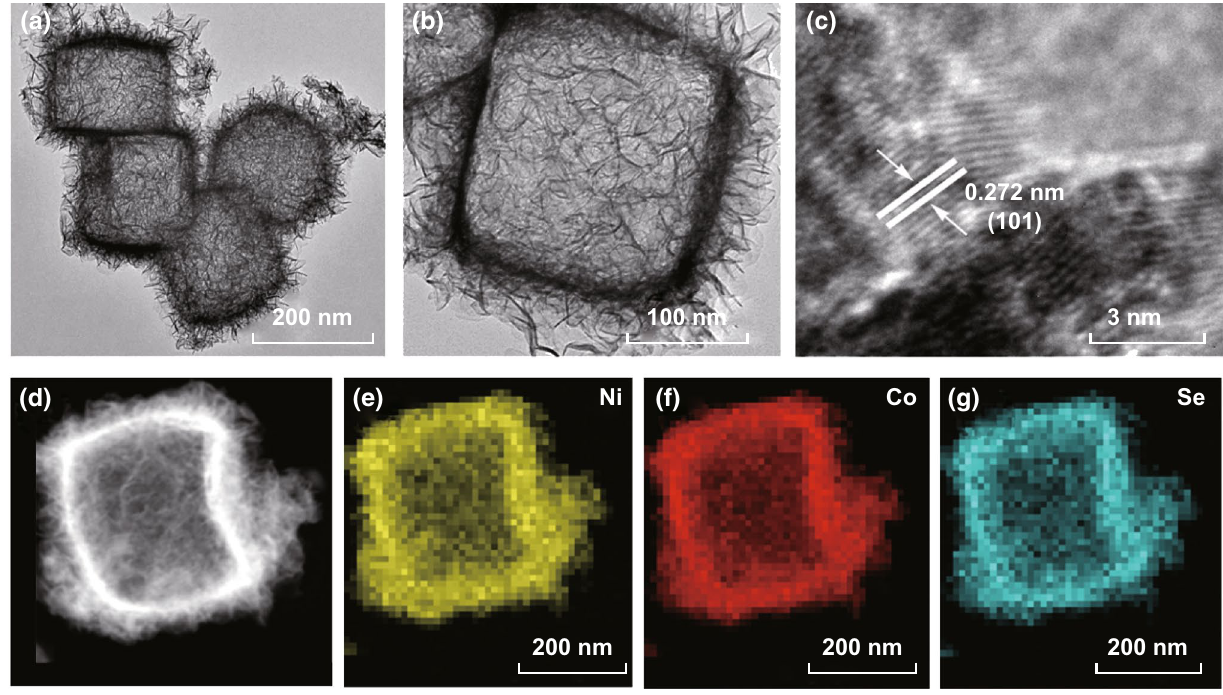
Fig. 2 a – c Representative TEM and HRTEM images of the Ni 0.2 Co 0.8 Se nanocages. d HAADF‑STEM image of Ni 0.2 Co 0.8 Se and e – g the cor‑ responding elemental mapping images of Ni, Co, and